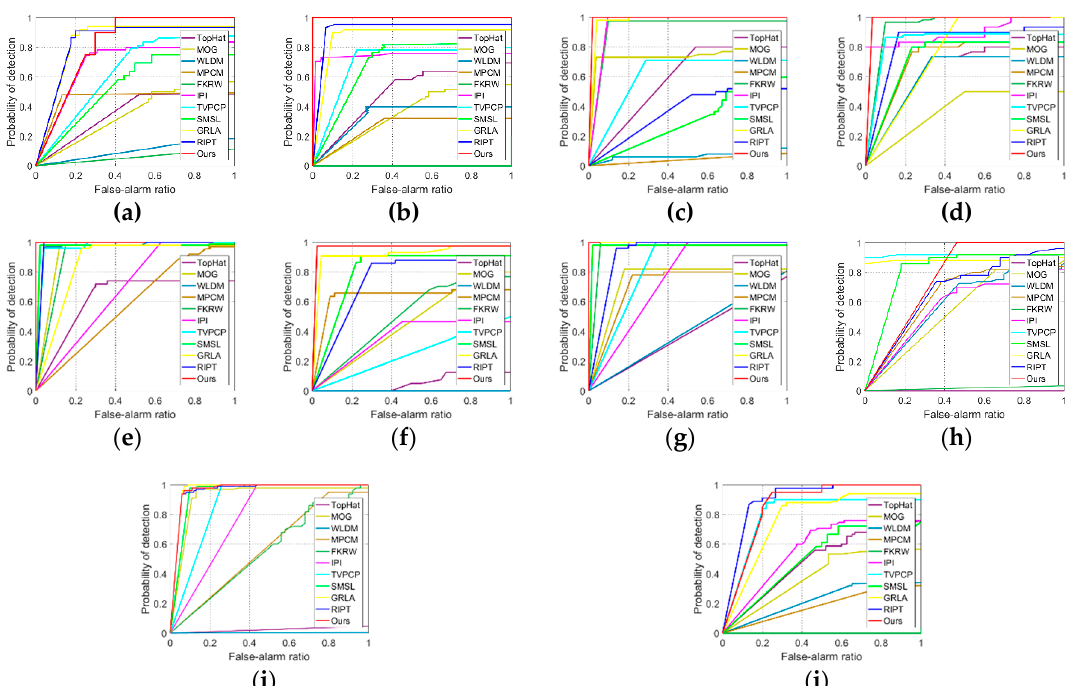
Figure 11. Comparison of the ROC results of different tested methods conducted on 10 sequences. ( a )–( j ): Sequences 1–10.